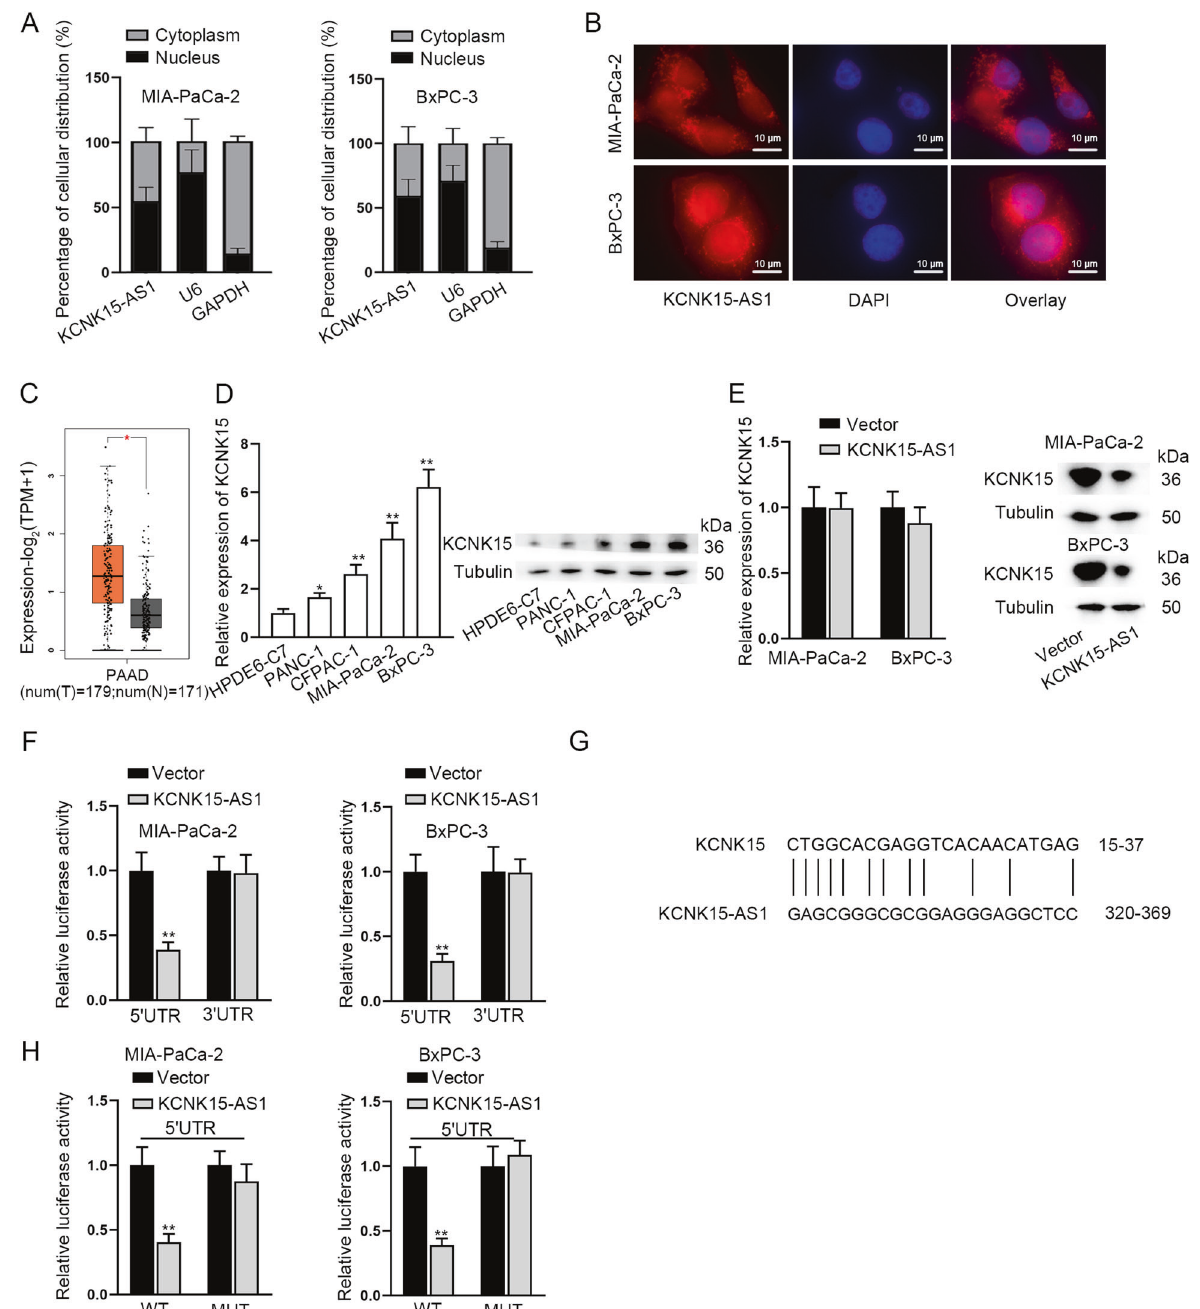
Fig. 4 KCNK15-AS1 represses KCNK15 translation via binding to KCNK15 5 ’ UTR. A , B Subcellular fractionation and FISH assays (Scale bar: 10 μ m) were performed to identify the cellular location of KCNK15-AS1 in PC cells. C Data of KCNK15 expression in PAAD tissues (N = 179) and normal tissues ( N = 171) was obtained from GEPIA 2. D KCNK15 expression in human PC cells relative to HPDE6-C7 cells was determined by RT-qPCR and western blot. E RT-qPCR and western blot analyzed the in fl uence of KCNK15-AS1 on KCNK15 expression in PC cells. F Luciferase activities of KCNK15 5 ’ UTR and KCNK15 3 ′ UTR were detected in PC cells with KCNK15-AS1 overexpression. G Binding sequences between KCNK15-AS1 and KCNK15 5 ’ UTR was shown. H Luciferase activities of KCNK15 5 ′ UTR-WT (with wild-type binding sites) and KCNK15 5 ′ UTR-MUT (with mutated sites) were detected in PC cells after KCNK15-AS1 overexpression. * P < 0.05, ** P <